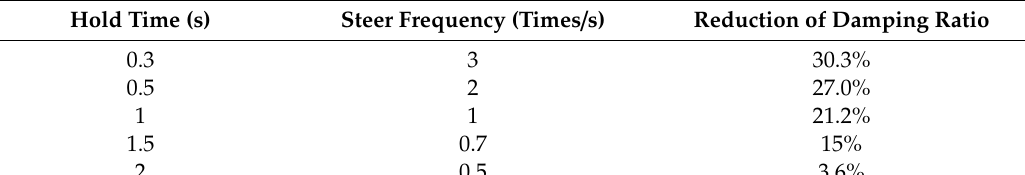
Figure 10. Course keeping under different control.